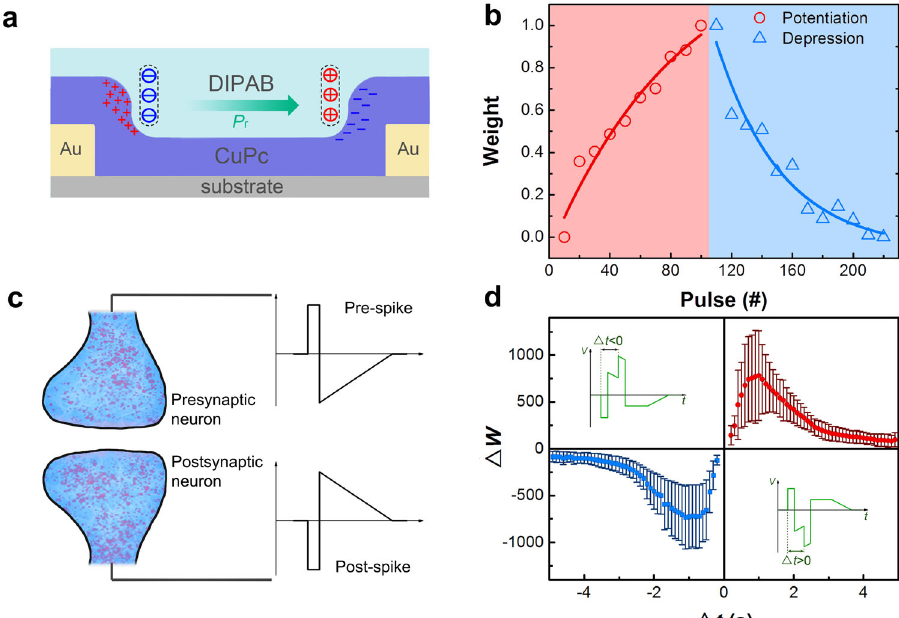
Fig. 4 Electrical synaptic characteristics. a Schematic view of the synaptic devices in which injected charges can move along the lateral interface under bias voltages. b Potentiation and depression behaviors with stimulus pulses for the MF/CuPc interfacial devices. c Schematic views of the horizontal devices with their electrodes acting as pre- and post-synaptic neurons of a synapse, respectively. Synaptic weights can be tuned by temporal correlation between pre- and post-spikes. d STDP measurements of the interfacial synaptic